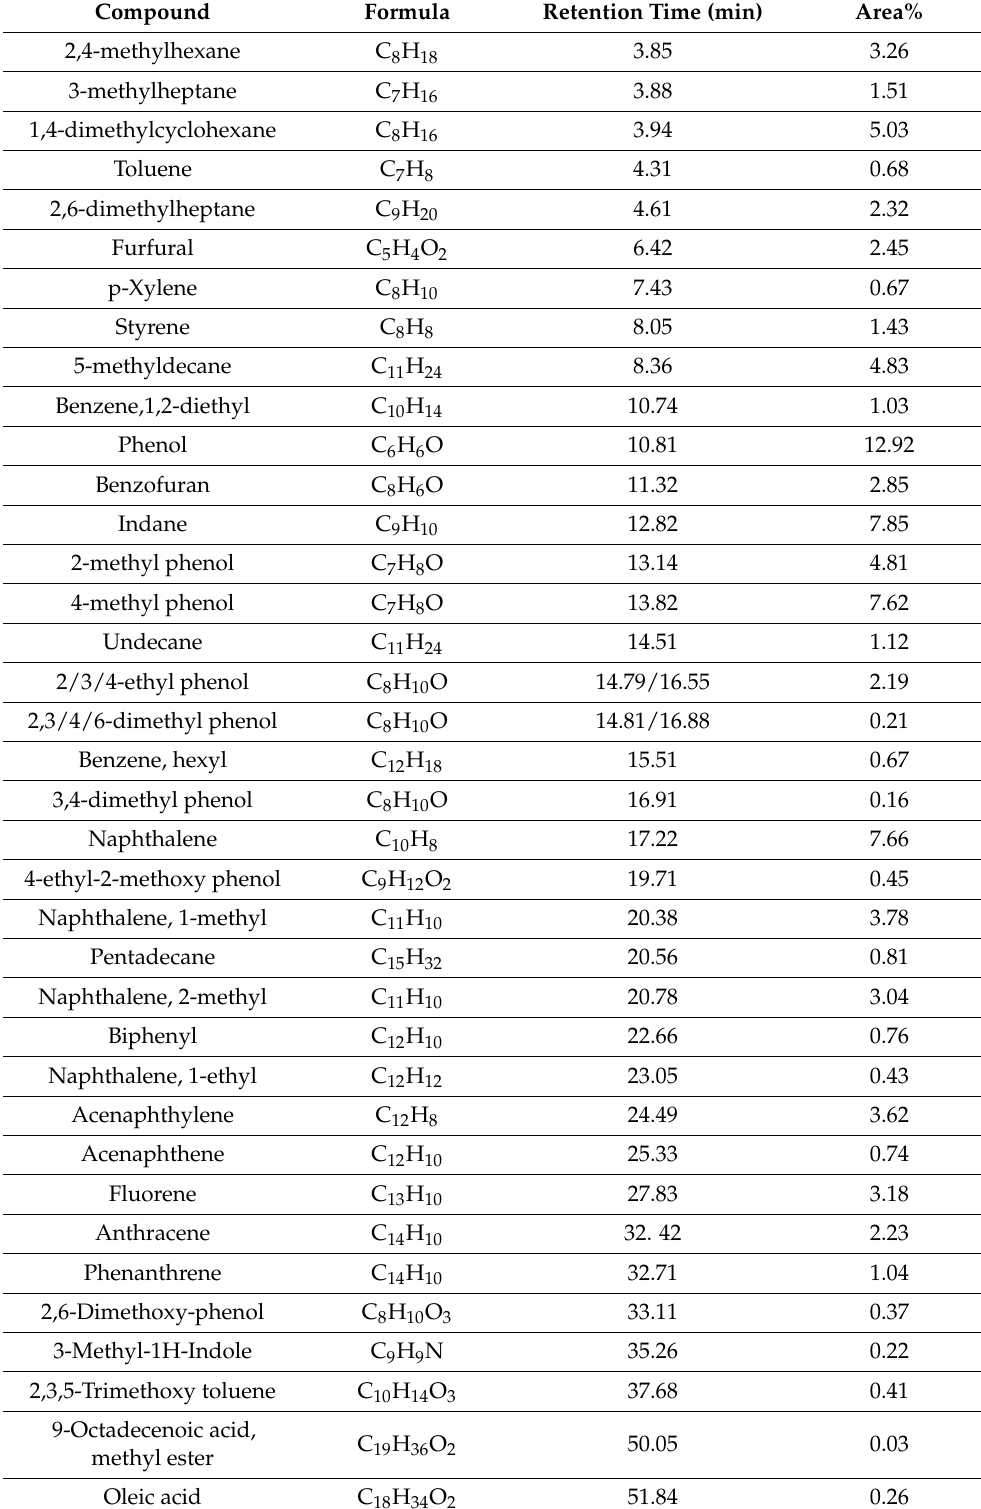
Table 6. Main chemical compounds identified in bio-oil produced from combined pyrolysis process (in situ and ex situ) of corn cobs biomass, nanocatalyst-to-biomass ratio (C/B) was